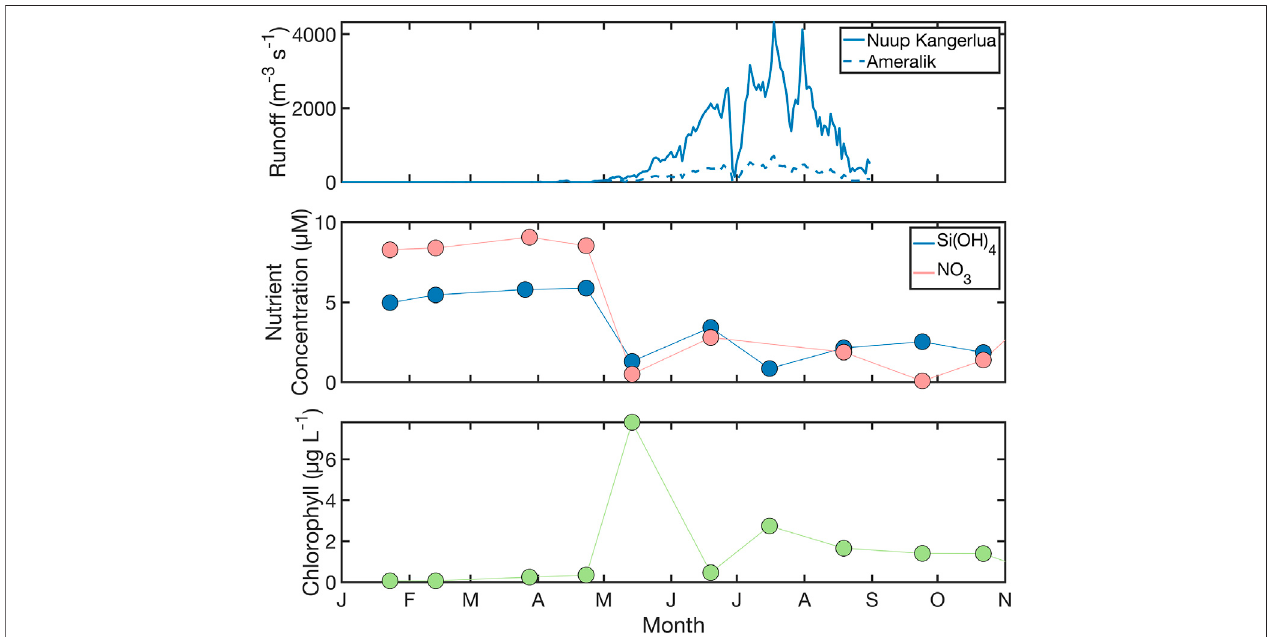
FIGURE 5 | The seasonal development of runoff (modelled); and nitrate, silicic acid and chlorophyll a concentrations (measured) for station GF3 in the mouth of Nuup Kangerlua. GF3 data is reported monthly by The Greenland Ecosystem Monitoring (GEM, 2021) Database, (https://data.g-e-m.dk/, last accessed August 2021). Modelled daily liquid discharge from Mankoff et al. (2020) refers to 2019 (see Supplementary Note ). Nutrient concentrations refer to 10 m, chlorophyll concentrations are a 0 – 20 m mean.